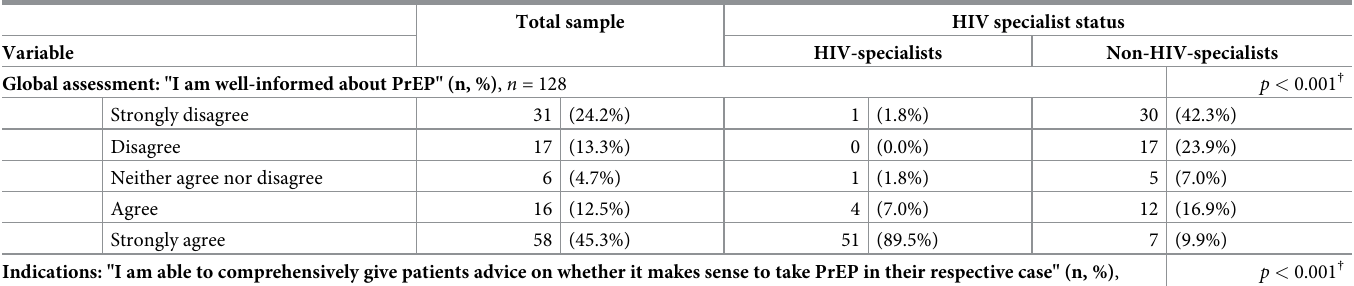
Table 4. Self-assessment of knowledge and counselling competence. Total sample HIV specialist status Variable HIV-specialists